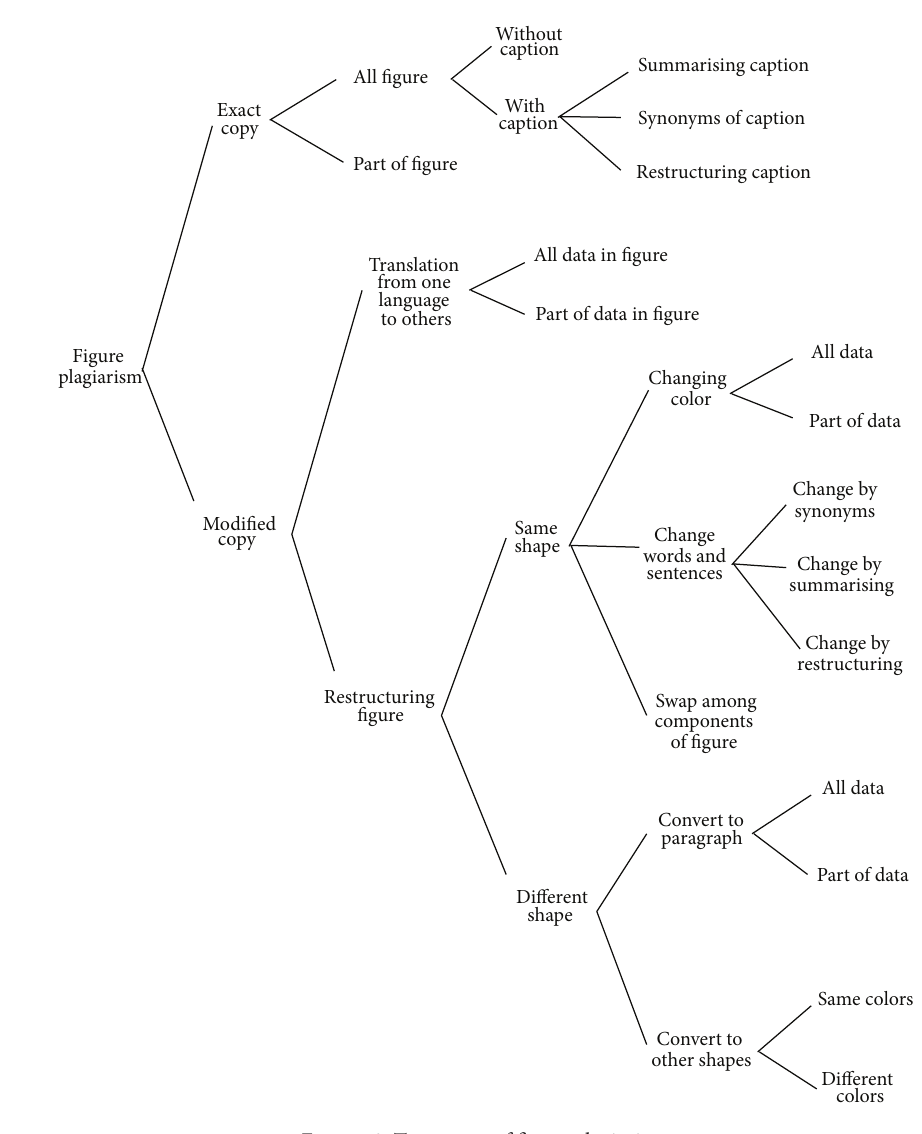
Figure 2: Taxonomy of figure